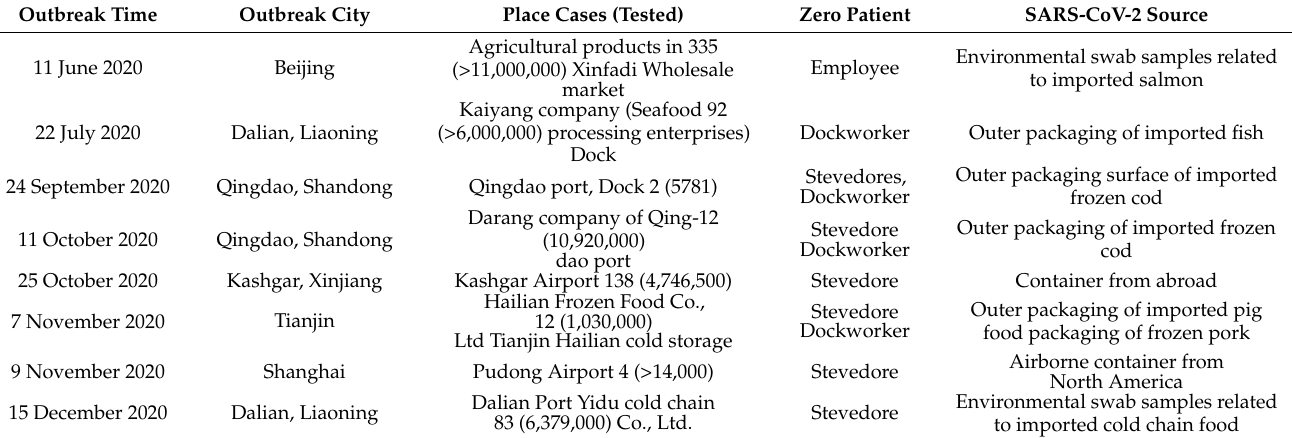
Table 1. Some case of imported cold food supply chain-related coronavirus disease cold chain